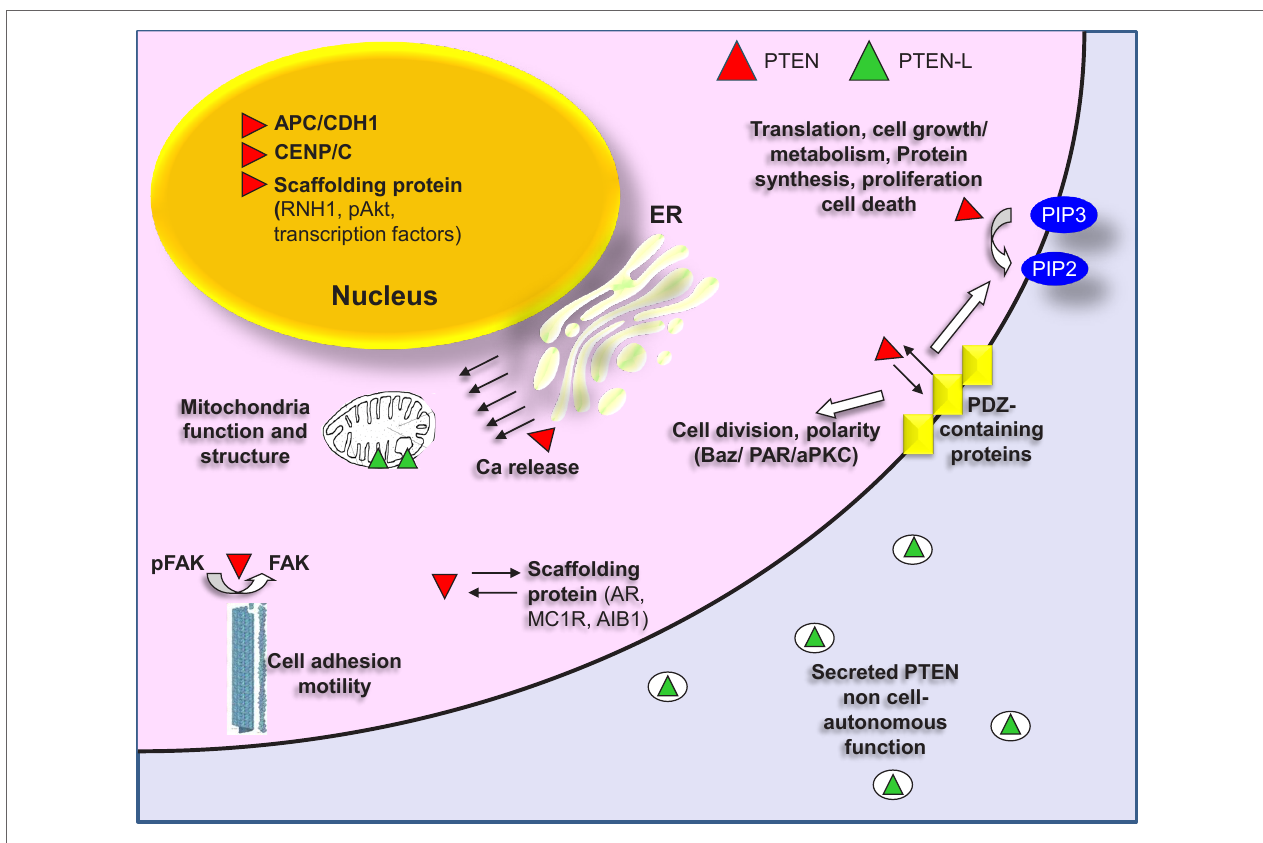
cases PTEN regulates the stability of these proteins by promoting their degradation. In the nucleus, PTEN also functions as a scaffolding protein. It interacts with transcription factors regulating their activity [p53, SMAD3, MTF-1 (metal-responsive transcription factor 1)]. It correlates with miRNA processing by interacting with RNH1 and interfering with the formation of Drosha complex and it promotes degradation of nuclear located proteins as in the case of pAKT. Nuclear PTEN interacts also with CENP/C promoting chromosomal integrity and positively regulates expression of Rad51, which reduces the incidence of spontaneous double-strand breaks (DSBs). Additionally, PTEN is required in the nucleus for the formation of the APC/CDH1 complex, which is a regulator of cellular senescence and cell cycle. Canonical PTEN located in the ER is associated with Ca 2 + release and regulation of apoptosis through interaction with the inositol 1,4,5-trisphosphate receptors (IP3Rs). A translational variant of PTEN (PTEN-L, green) is secreted and associated with the mitochondria. PTEN-L exerts its phosphatase activity outside the cell boundaries, whereas in mitochondria it is related to mitochondria structure and energy